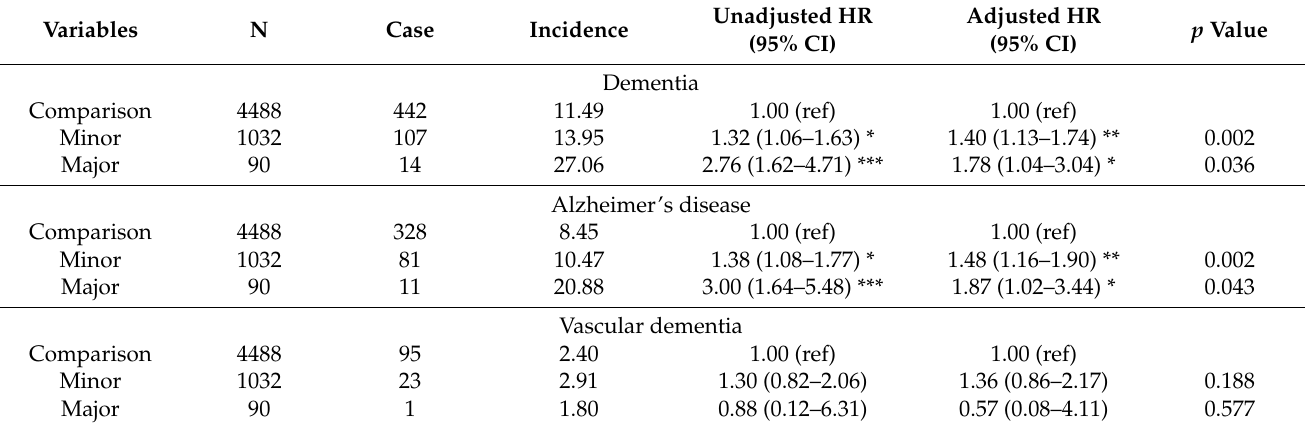
Table 5. Incidence per 1000 person-years and HR (95% CI) of dementia, Alzheimer’s disease and vascular dementia according to surgery